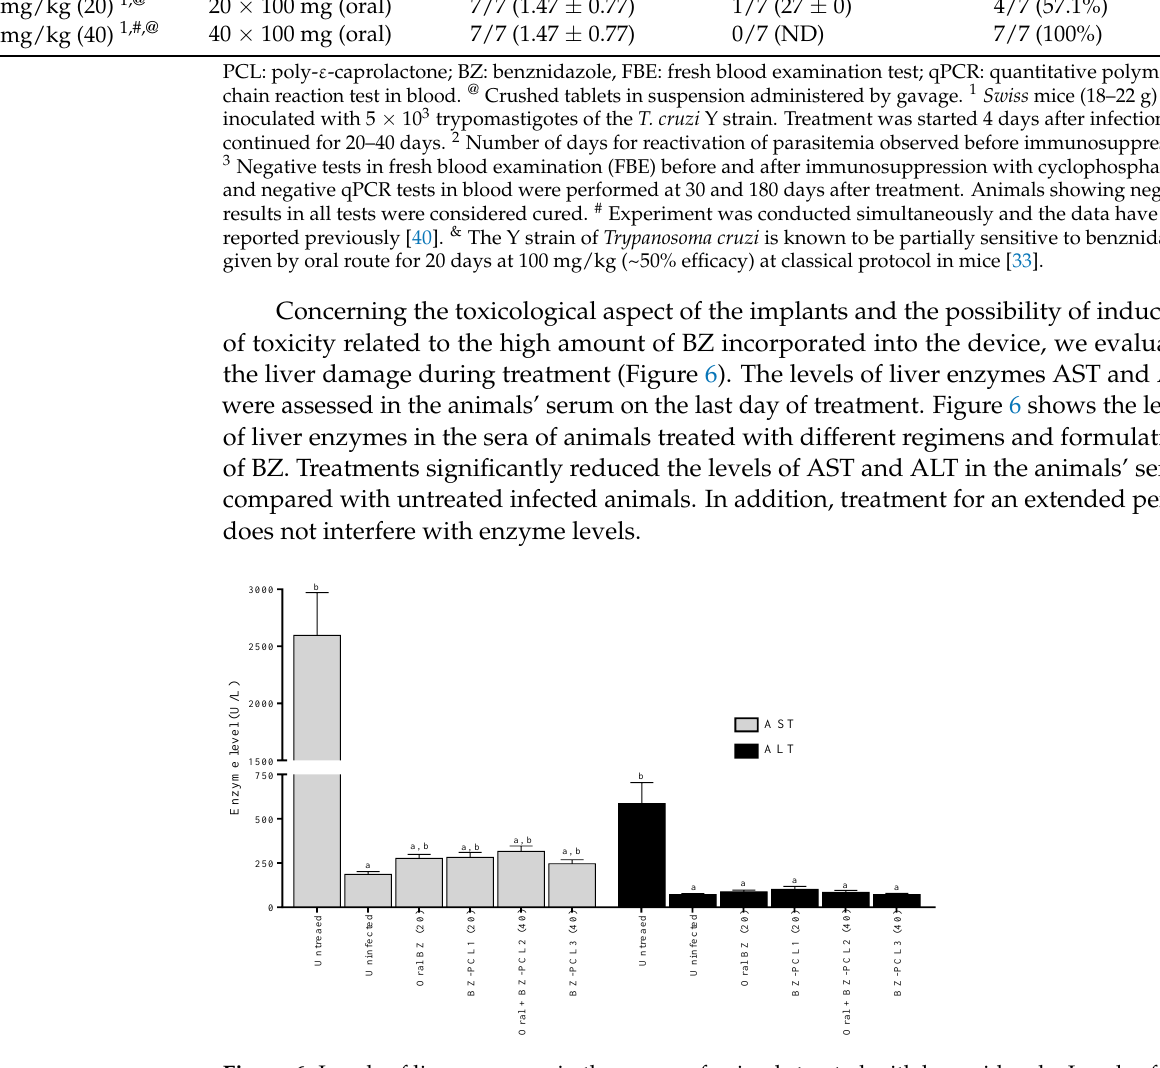
Figure 6. Levels of liver enzymes in the serum of animals treated with benznidazole. Levels of AST (aspartate aminotransferase) and ALT (alanine aminotransferase) detected in the serum of animals infected by strain Y, treated for 20 or 40 days with benznidazole. The samples were collected on the last day of treatment. The AST and ALT levels in untreated animals were measured on the 15th day of infection. a = significant difference from infected untreated; b = significant difference from uninfected untreated control. Figure 7 shows the profiles of plasmatic concentration of BZ following time during 40 days of treatment with oral doses (100 mg/kg/day) or with subcutaneous implant BZ- PLC3 in healthy mice or in T. cruzi infected mice. There is a clear difference ( p < 0.05) between plasma exposure (area under the curve) after treatment with implants and oral administration. Implants maintain higher BZ plasmatic concentrations in the first days and a slower decay after five days compared with oral daily doses. These differences in BZ plasma concentrations are even higher in infected mice than in healthy mice. The dis- ease plays a role in the body’s exposure to BZ with subcutaneous implant formulations. This effect is not clearly observed in the treatment by oral route.